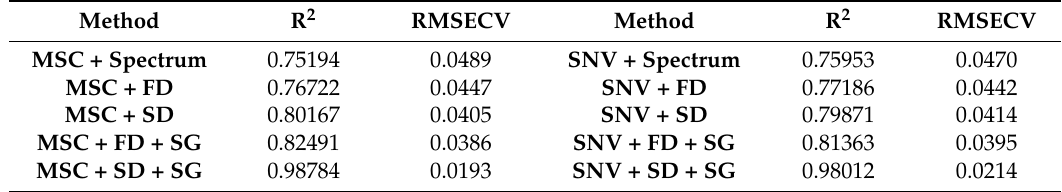
Table 3. The influence of different pretreatment methods on the quantitative model (4500–8500 cm − 1